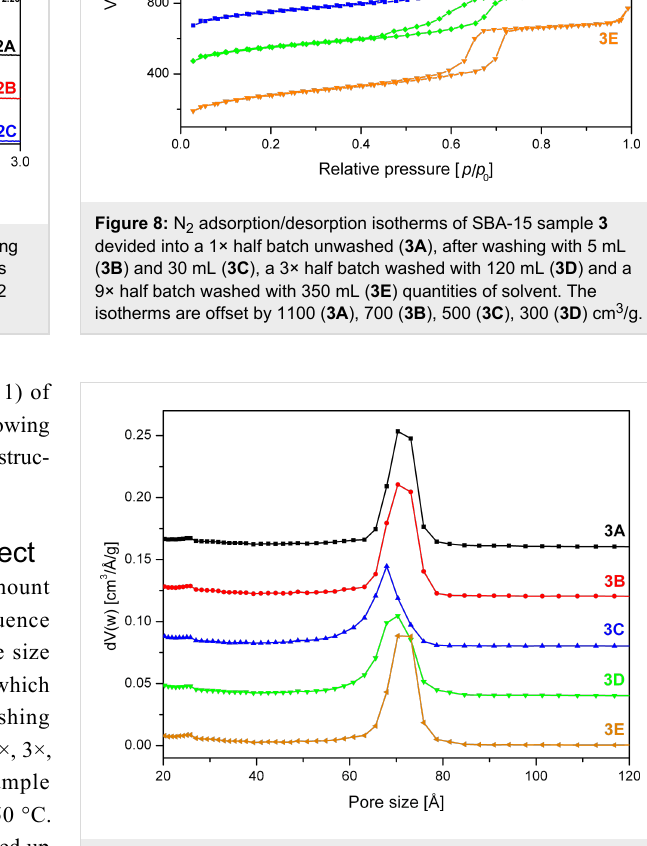
Figure 9: NLDFT pore size distribution of SBA-15 sample 3 calculated from the adsorption branch of the isotherm. The sample was devided into a 1× half batch unwashed ( 3A ), after washing with 5 mL ( 3B ) and 30 mL ( 3C ), a 3× half batch washed with 120 mL ( 3D ) and a 9× half batch washed with 350 mL ( 3E ) quantities of solvent. The pore size distributions are offset by 0.16 ( 3A ), 0.12 ( 3B ), 0.08 ( 3C ) and 0.04 ( 3D ) cm 3